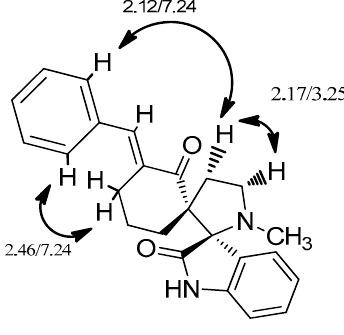
Figure 4. The key NOE contacts for 7 .